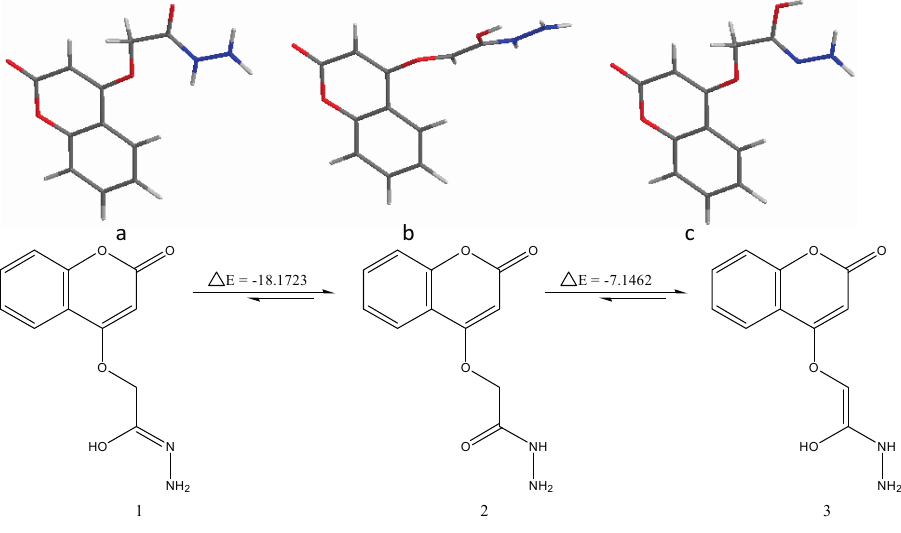
Figure 8. Probable conformational isomers of the N -acylhydrazone of EFCI (3-dimensional structures (a, b, c) and geometrical isomers (1, 2,